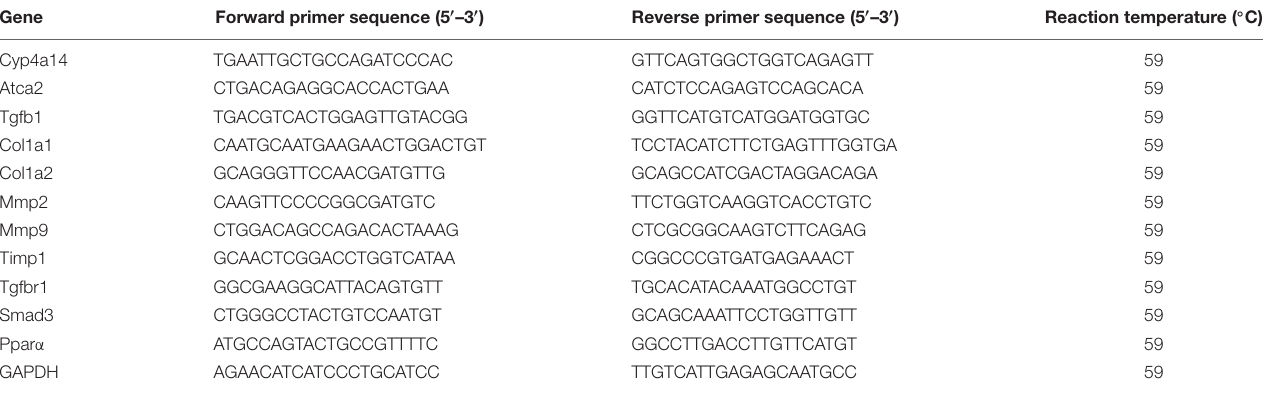
TABLE 1 | Sequences of primers used for real-time quantitative PCR. Gene Forward primer sequence (5 (cid:48) –3 (cid:48) ) Reverse primer sequence (5 (cid:48) –3 (cid:48) ) Reaction temperature ( ◦